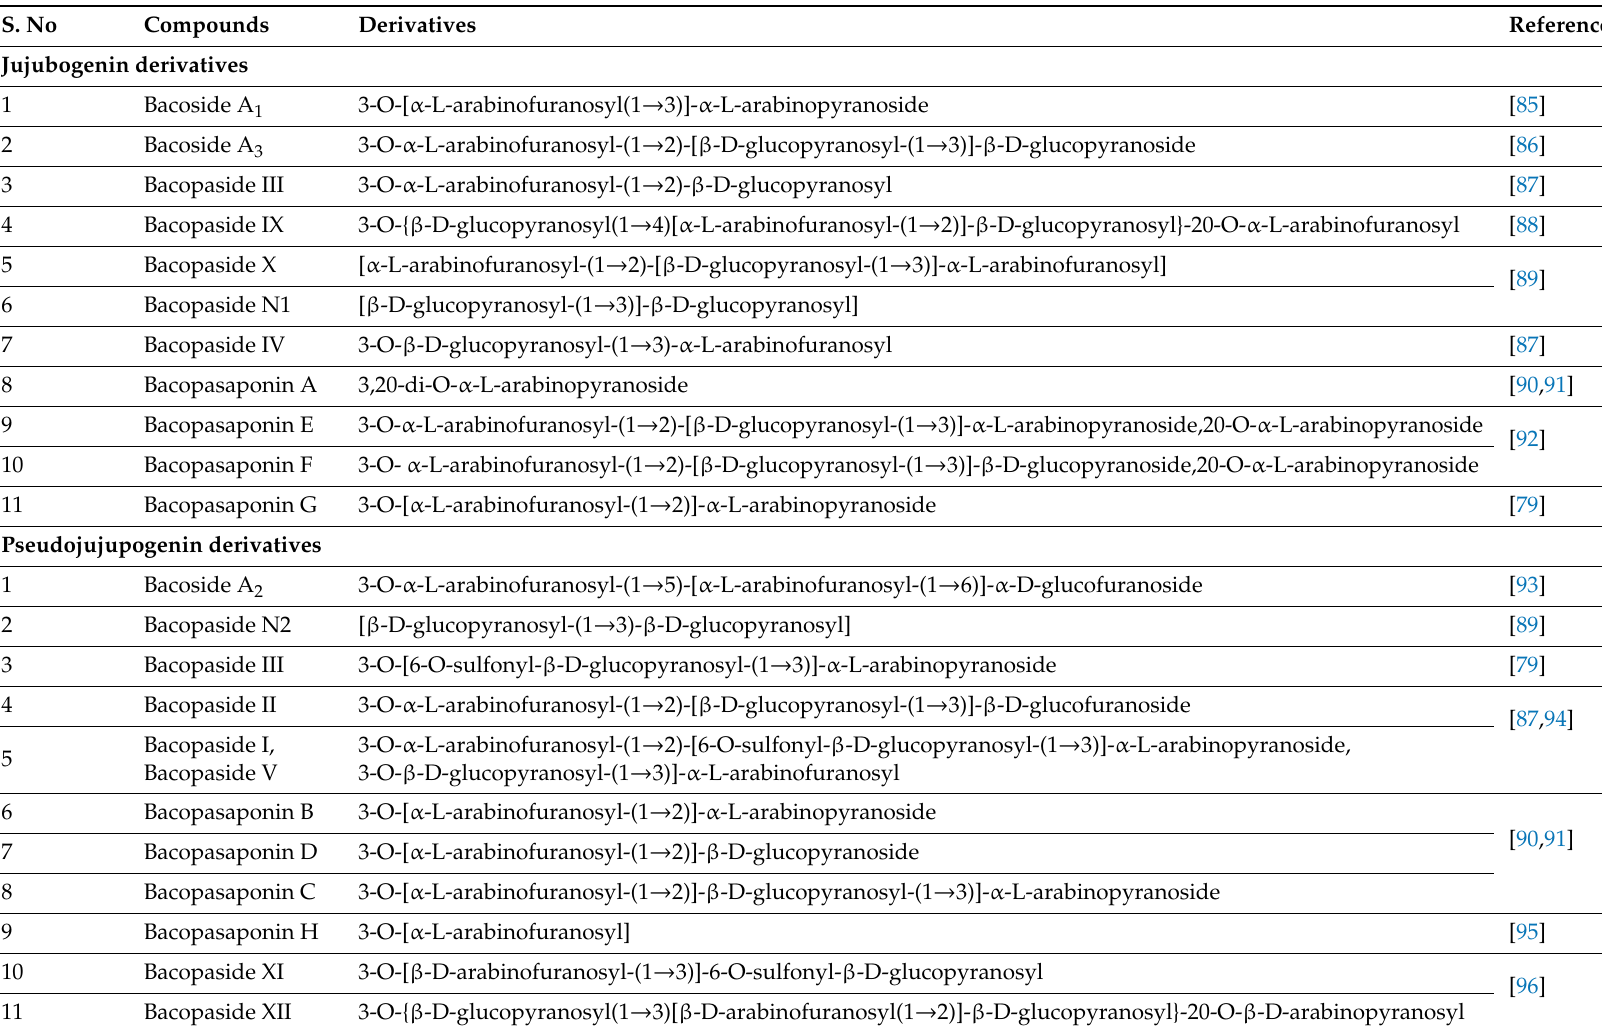
Table 2. Characterization and isolation of Saponins from the alcoholic extract reported from B.